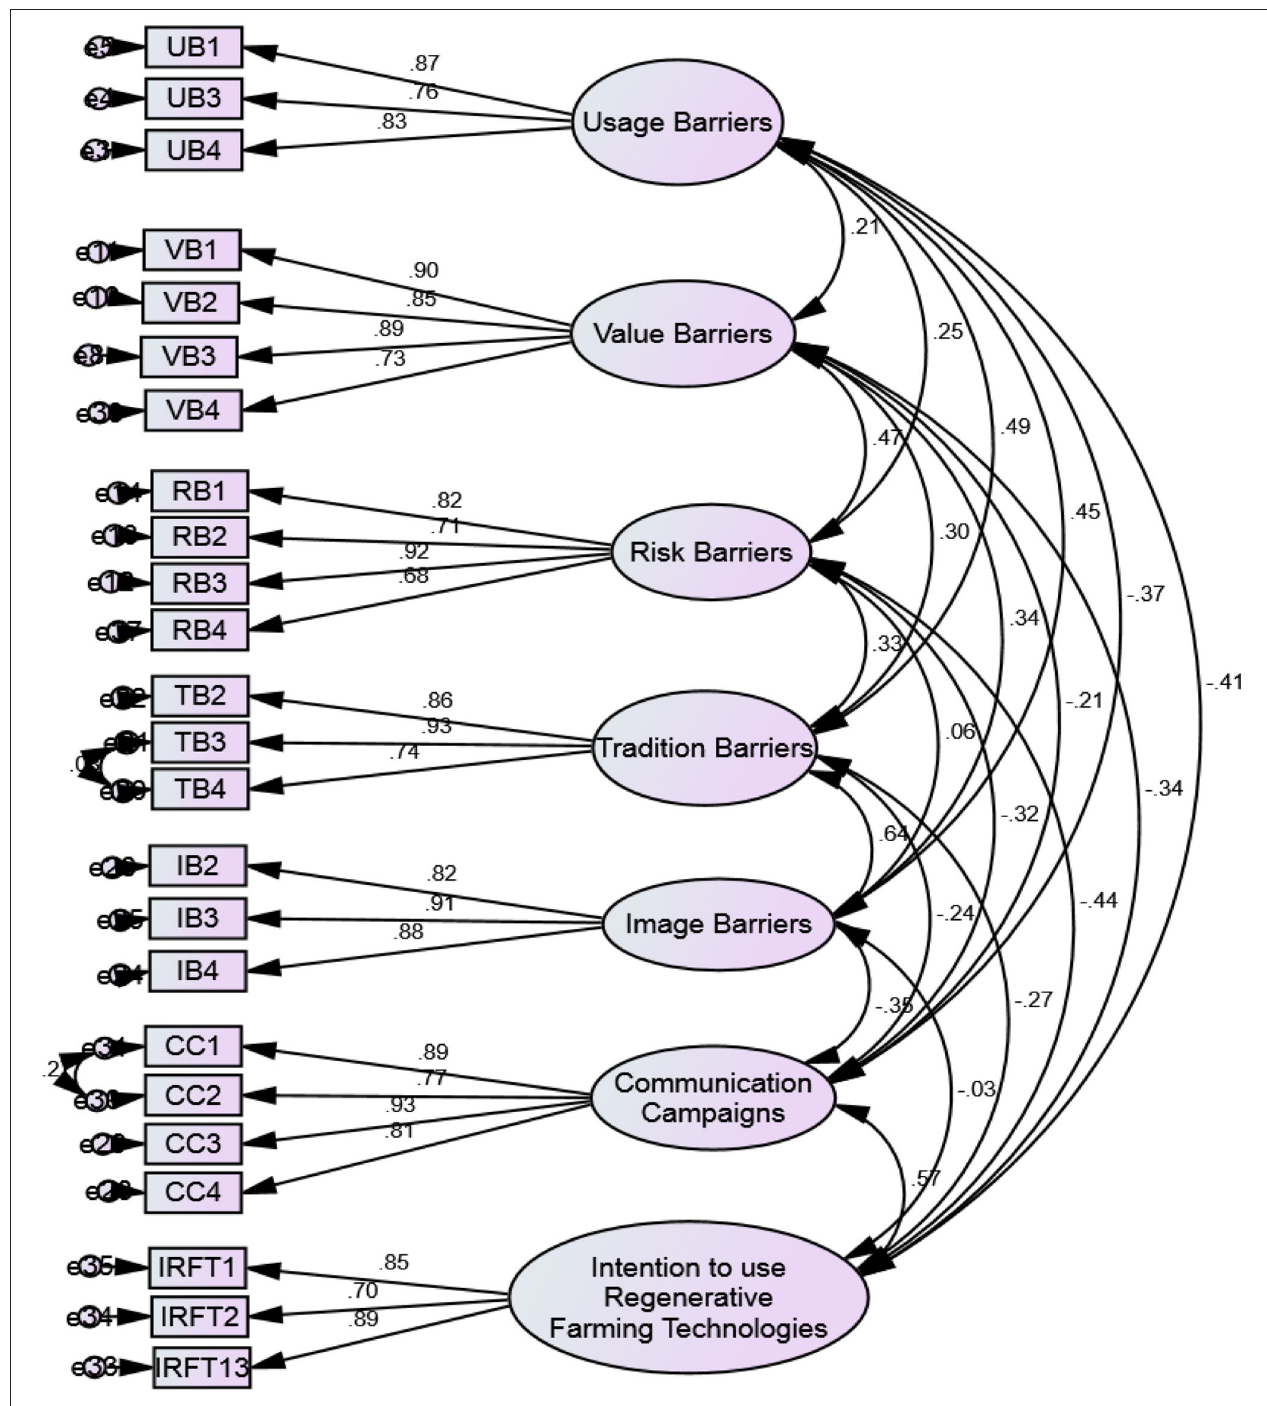
FIGURE 2 | Measurement